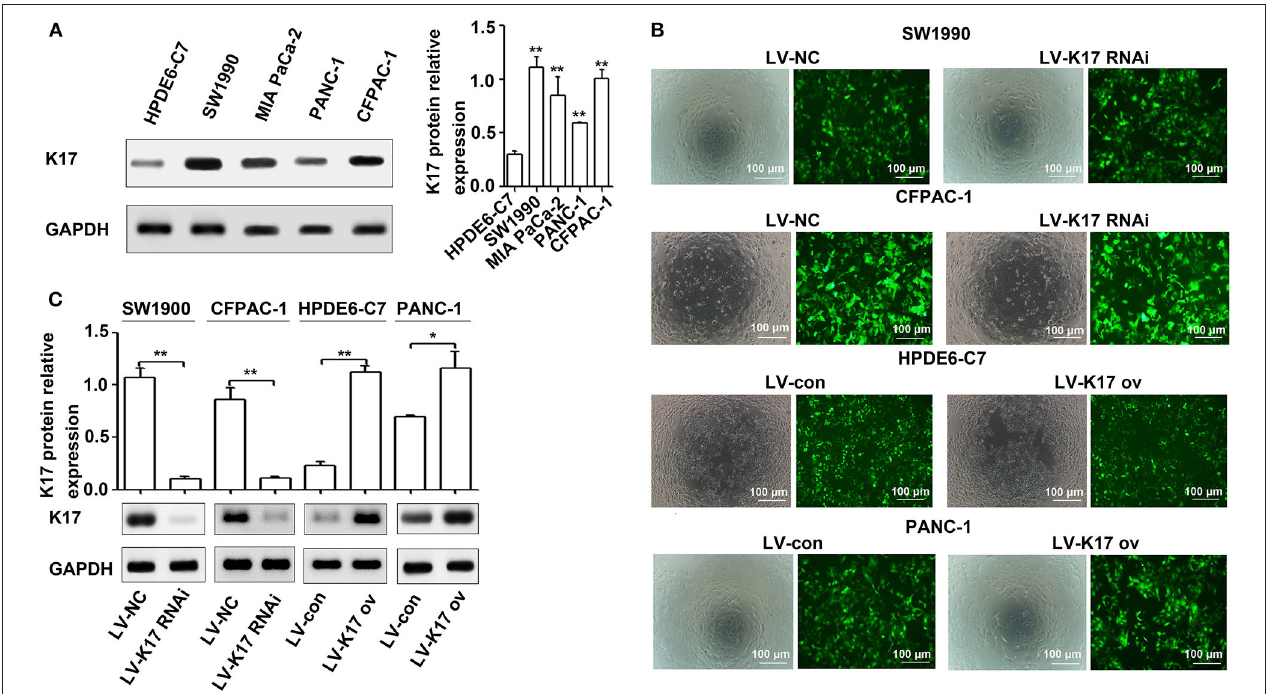
FIGURE 3 | K17 protein was upregulated in pancreatic cancer cell lines. (A) The expression levels of K17 protein in four pancreatic cancer cell lines (CFPAC-1, MIA PaCa-2, PANC-1, and SW990) and one normal pancreatic cell line (HPDE6-C7) were determined by western blot analysis. (B) SW1990 and CFPAC-1 cells were infected with LV-K17 RNAi and LV-NC at an MOI of 20, and then were selected by puromycin treatment to establish stable K17 konckdown cell lines. HPDE6-C7 and PANC-1 cells were infected with LV-K17 ov and LV-con at an MOI of 30, and then were selected by puromycin treatment to establish stable K17 overexpressing cell lines. × 100, Scale Bar = 100 µ m. (C) Western blot analysis was used to determine K17 protein expression in SW1990 and CFPAC-1 cells infected with LV-K17 RNAi and in HPDE6-C7 and PANC-1 cells infected with LV-K17. * P < 0.05, and ** P <